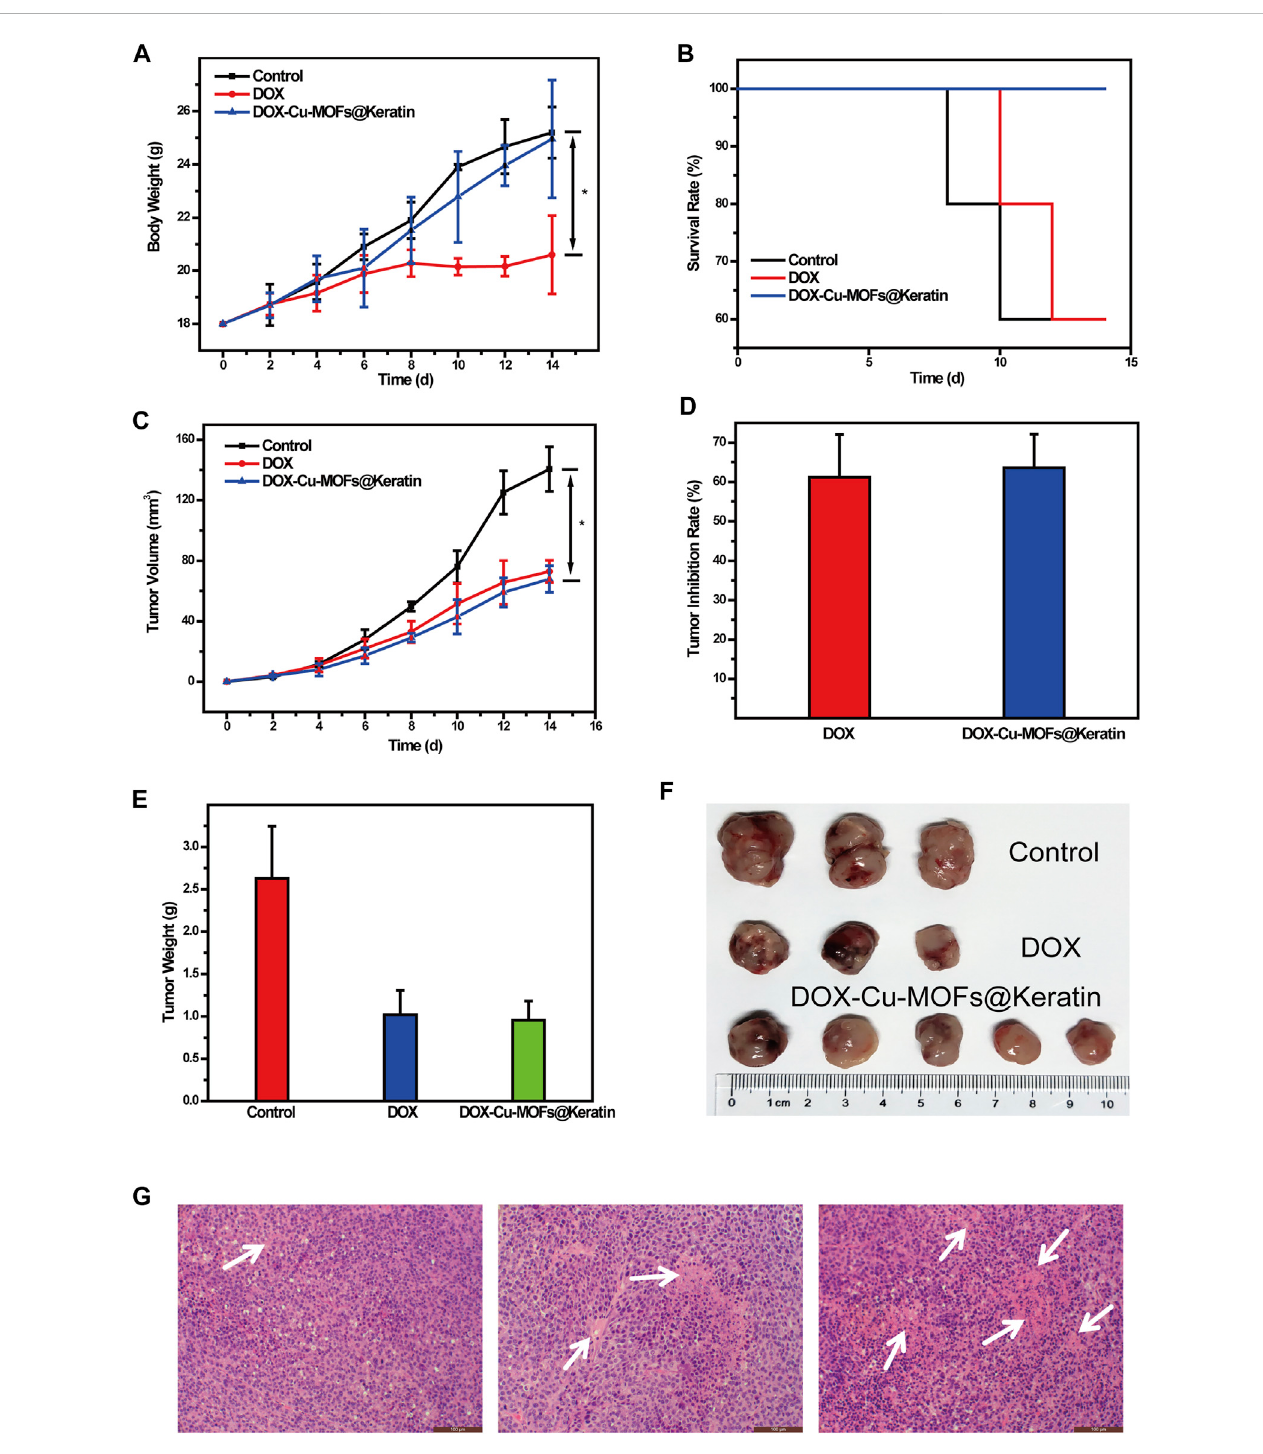
FIGURE 8 Anti-tumoref fi cacyofDOX-Cu-MOFs@Keratinonthetumor-bearingmice. (A) bodyweightoftumor-bearingmice( n =5,mean± SD); (B) survivalrates ofmiceafterthetreatment; (C) tumorvolumeofthetumor-bearingmice; (D) tumorinhibitionrate; (E) weightoftheextractedtumorscollectedfromdifferent groupsattheenddayofthetreatment; (F) photographsoftumorscollectedfromdifferentgroupsofmiceattheenddayofthetreatment;and (G) H&Estained tumor tissues harvested from mice with different